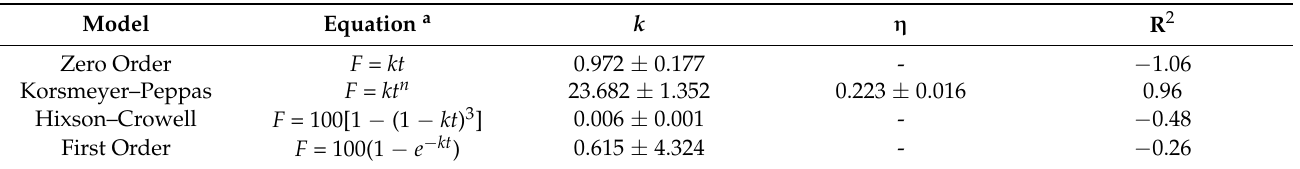
Table 1. Kinetic models used for analysis of CIP release from ZnO@ZIF-8 and their respective calculated